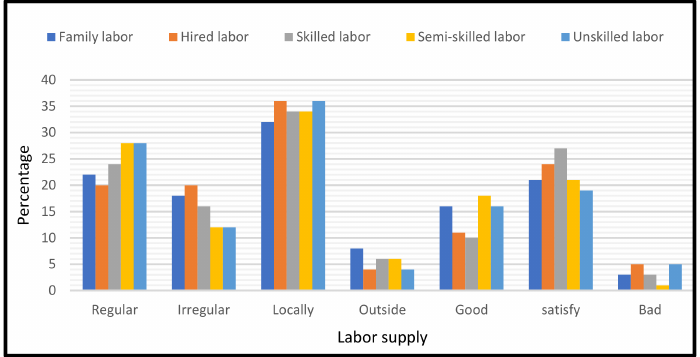
Figure 18. Labor supply situation.